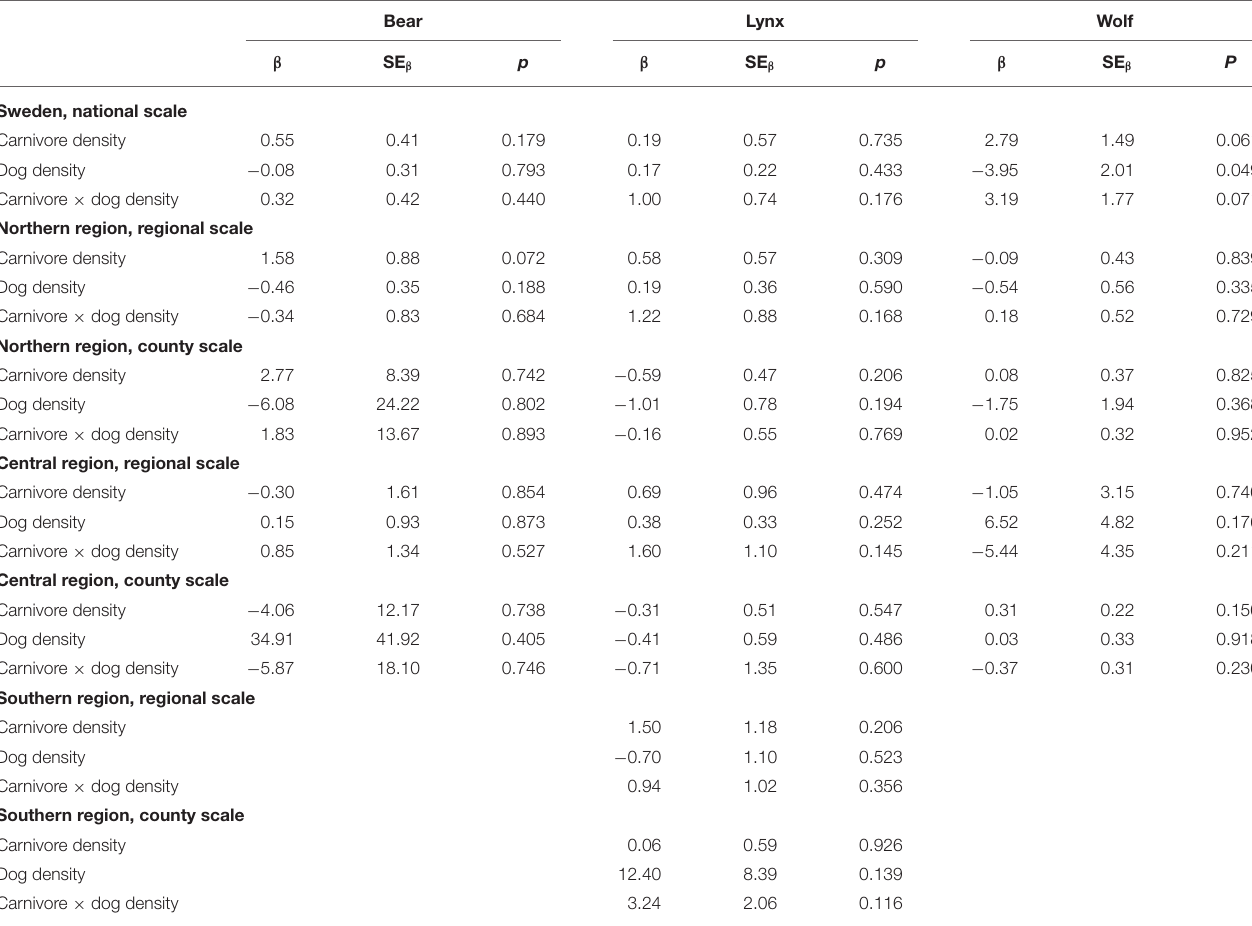
TABLE 3 | Beta coefficients describing the relationships between number of damaged domestic dogs by brown bears, Eurasian lynx and gray wolves and densities of respective carnivore and dogs (proxied by the density of dog owners), as well interaction coefficients describing if the density of dogs influences the relationship between number of damaged dogs and densities of